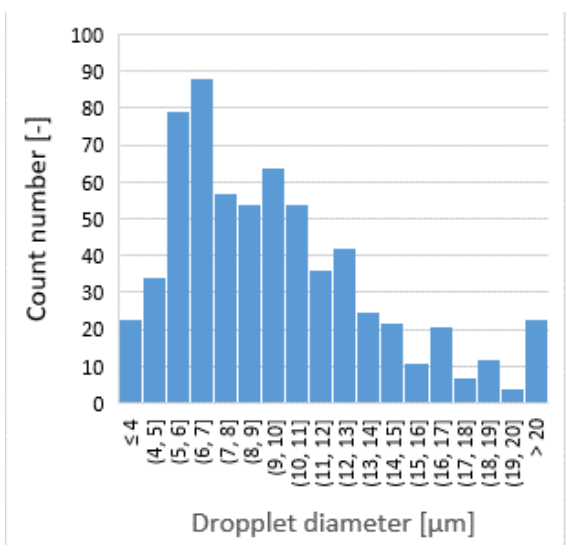
Fig. 4 The resulting size histogram.